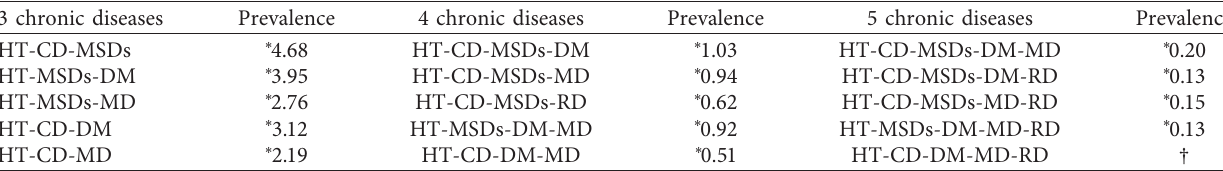
Table 3: Highest prevalence ∗ of chronic diseases (SABE study, municipality of São Paulo,